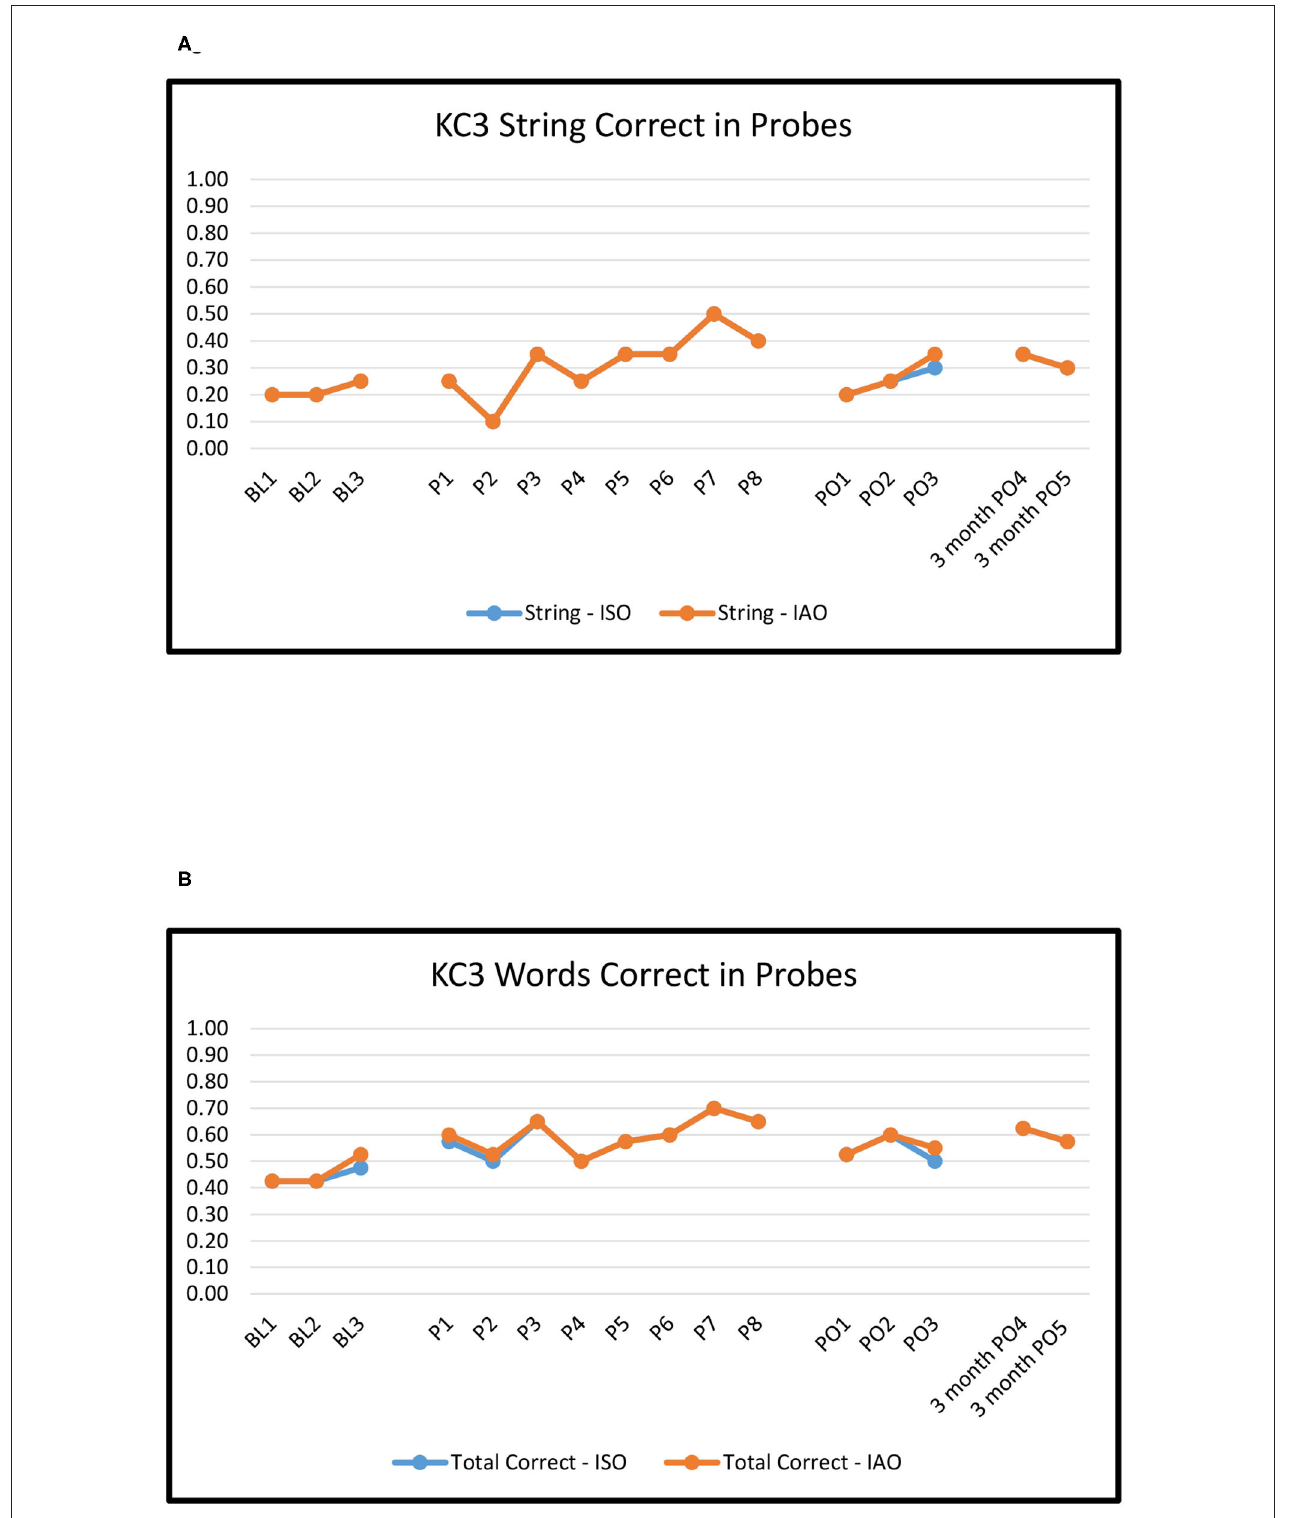
FIGURE 3 | KC3: Proportion of word strings (A) and words (B) correct in baseline, treatment, post-treatment, and 3 months follow-up probes.